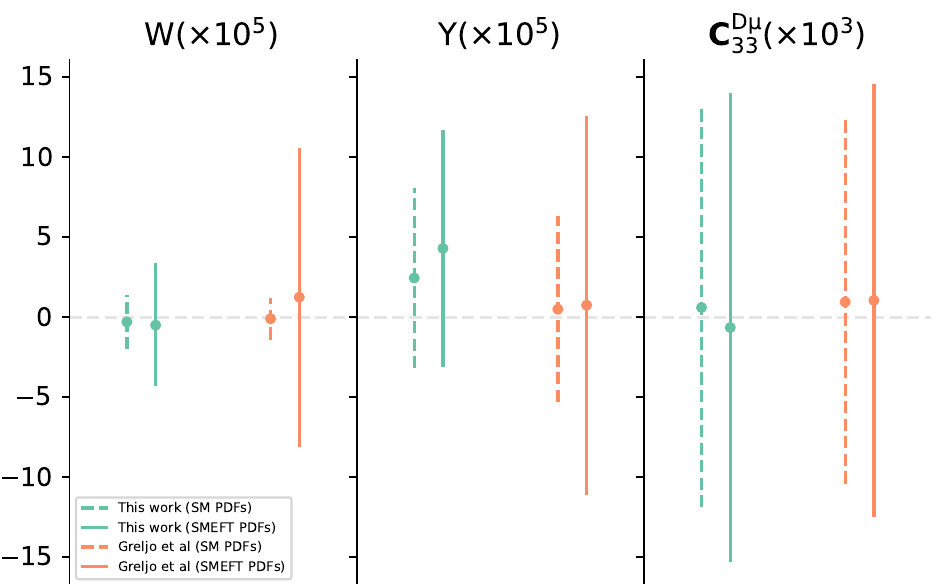
Figure 12 . Comparison of 95% C.L. bounds between this study (in green) and those determined in by Greljo et al. in ref. [17]. The W and Y bounds are determined simultaneously in the HL-LHC scenario, C Dµ is fitted individually including SMEFT quadratic terms in the HL-LHC scenario. 33 The bounds obtained by keeping the PDFs fixed to the SM baseline (dashed lines) are compared to those obtained in a simultaneous fit of PDFs and Wilson coefficients (solid